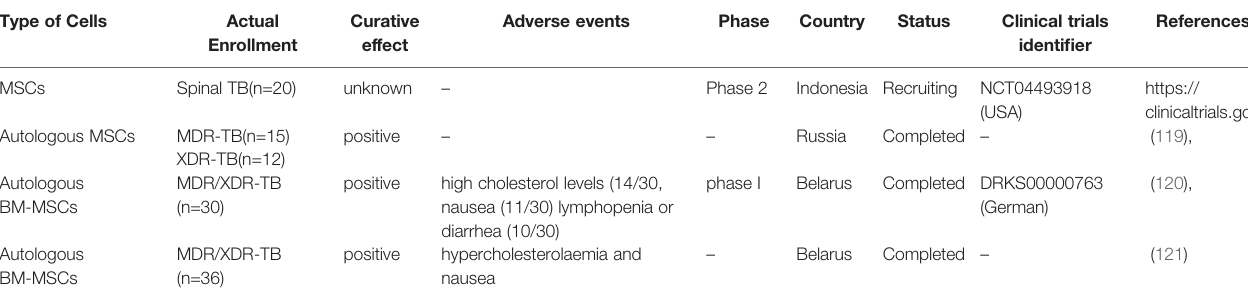
TABLE 2 | MSCs-Based Clinical Application for TB.